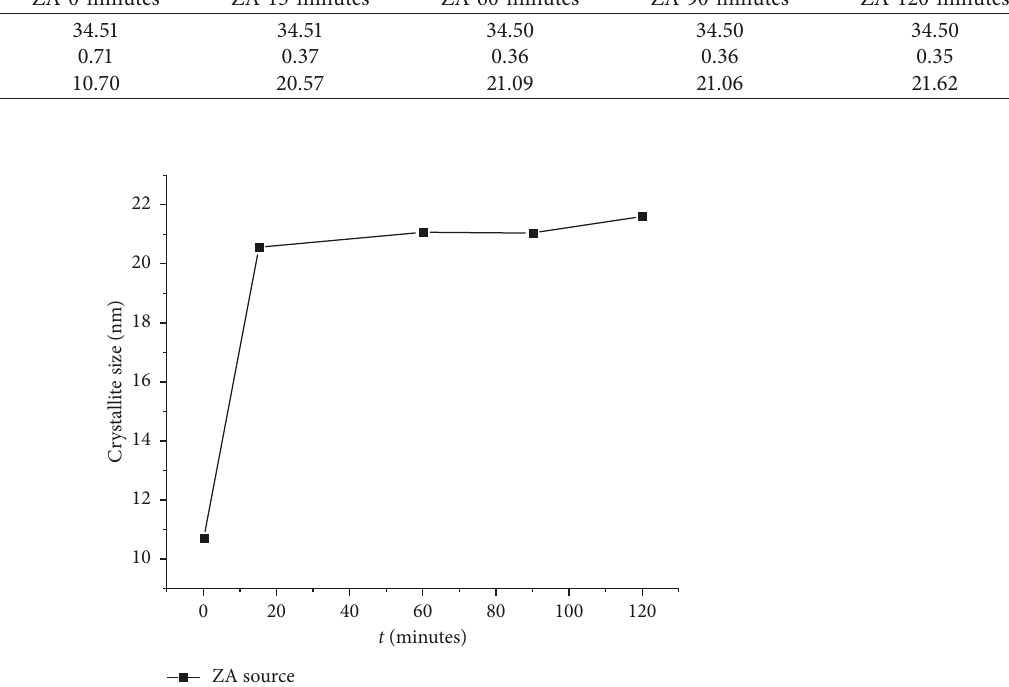
Figure 5: Linear plotting of crystallite size in a chart as a function of growth time t for ZnO NRs grown from the ZA